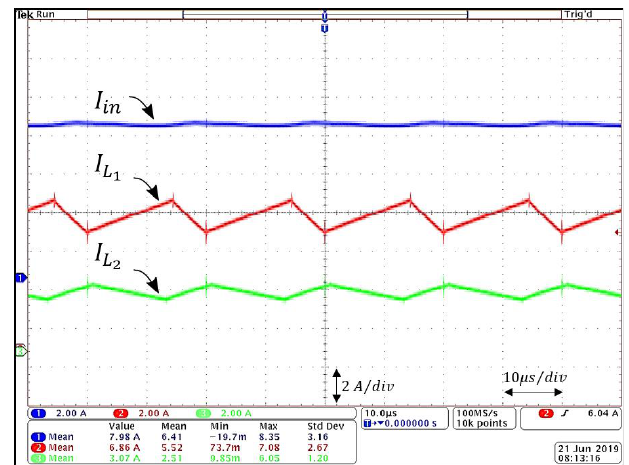
Figure 12. Graphic of currents through inductors and the input under the proposed input current control and ripple cancellation with I in = 8 A as set-point.